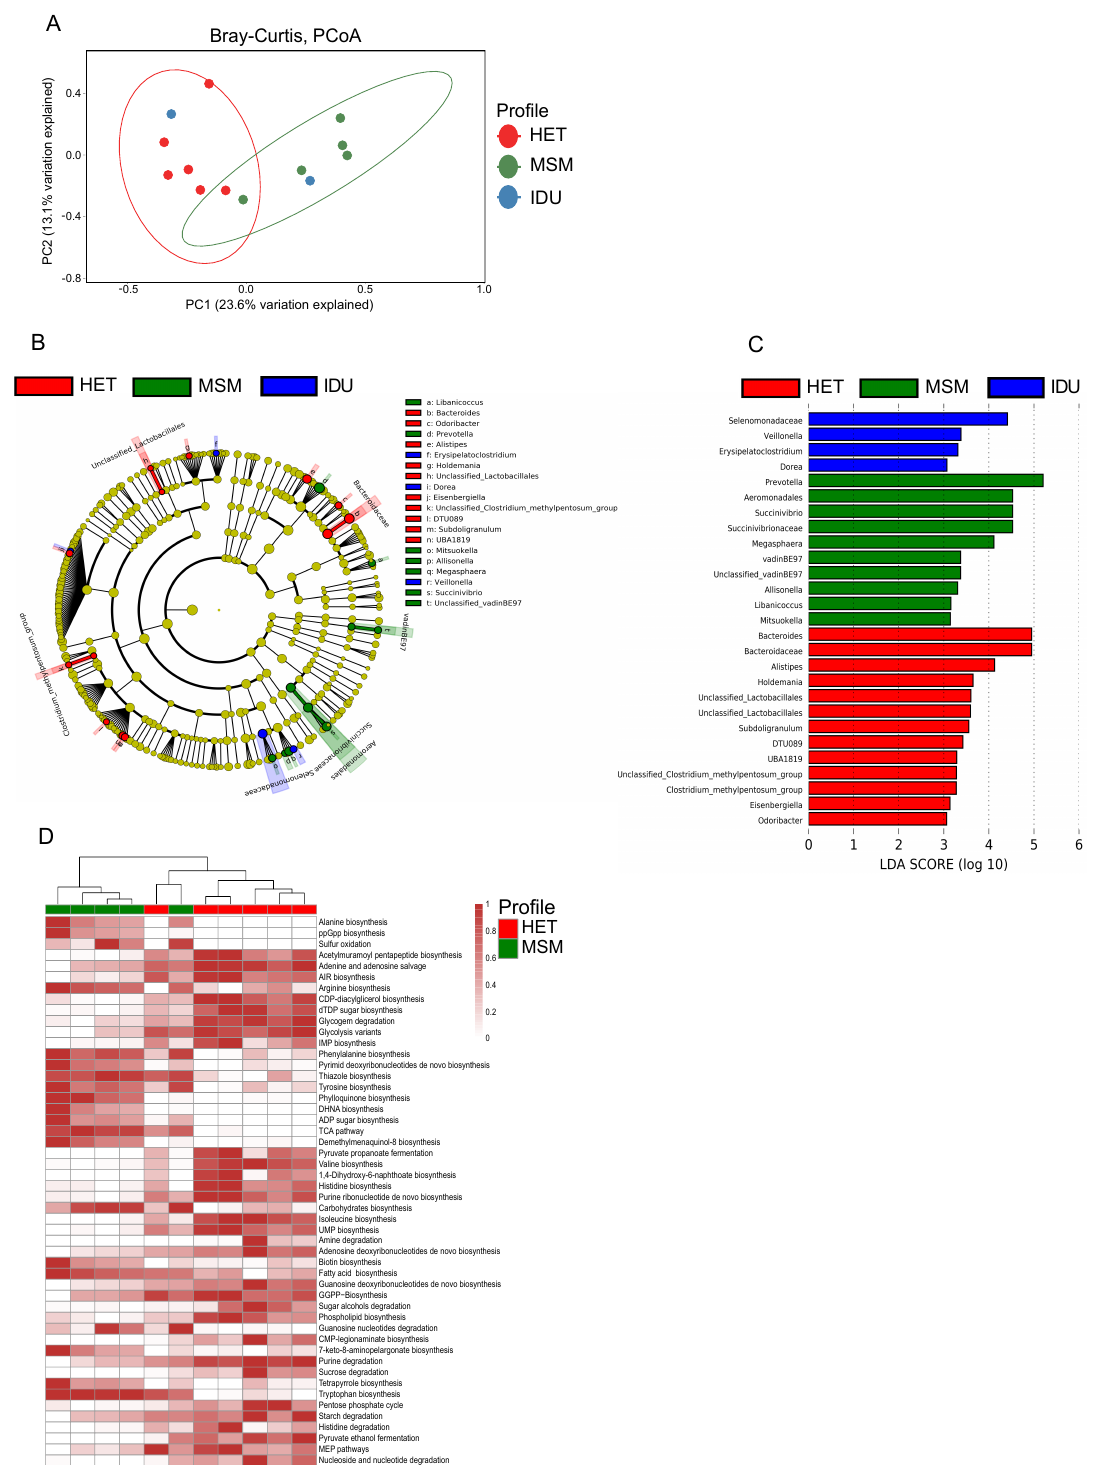
Figure 3. Effects of HIV transmission route on the gut microbiota of HIV-1 positive patients. Principal Coordinate Analysis (PCoA) of Bray Curtis distances among HET, MSM, and IDU groups ( A ). LEfSe results for the bacterial taxa that were significantly different between HET, MSM, and IDU groups. The cladogram shows differentially abundant taxonomic clades ( B ), and LDA scores showing significant differences between groups ( C ). Heatmap of relative abundance pathways that were significantly different between HET and MSM groups ( D ). Significant differences between the two groups were tested with Mann–Whitney test (FDR-adjusted p -value <